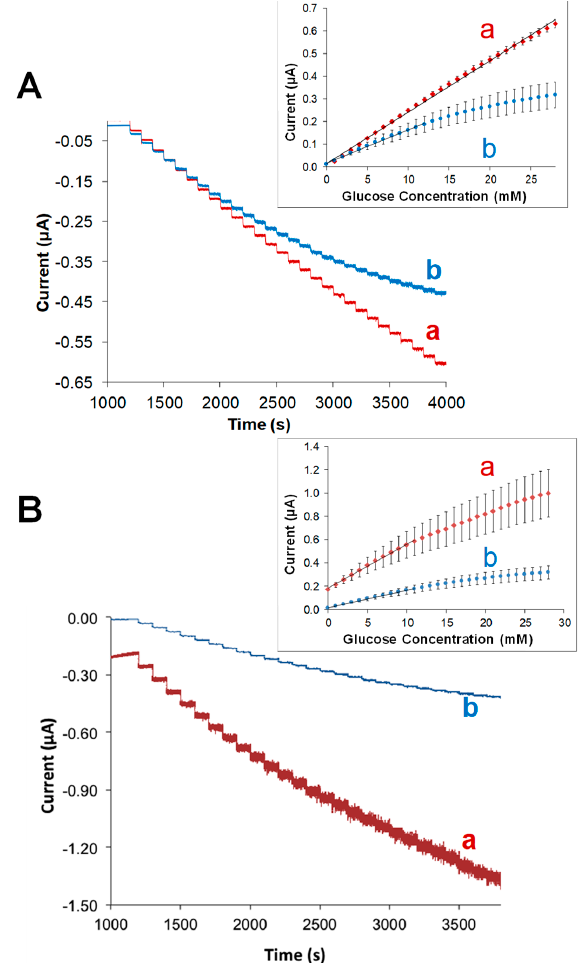
Figure 8. Amperometric I − t curves and corresponding calibration curves (insets) during successive 1 mM injections of glucose at ( A ) Pt macroelectrodes ( a ) vs. Pt-Ir wire electrodes ( b ) each modified with GOx-doped OTMS xerogel, undoped OTMS xerogel, polyphenol (PP), and polyurethane layer (PU) tested in synthetic urine; ( B ) The same LbL system at Pt-Ir wire electrodes (a) with and (b) without Pt-black underlayer and tested in synthetic urine. Note: Error bars represent standard error (n ≥